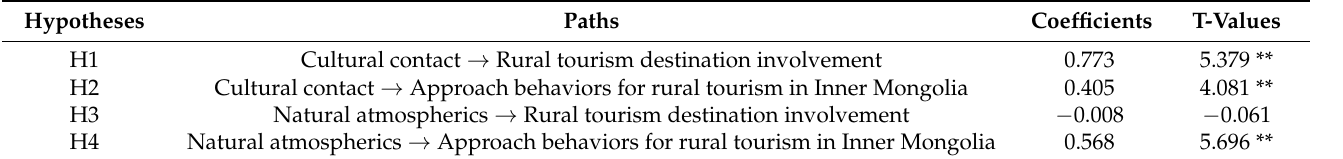
Table 4. Result of the structural analysis ( n = 300).